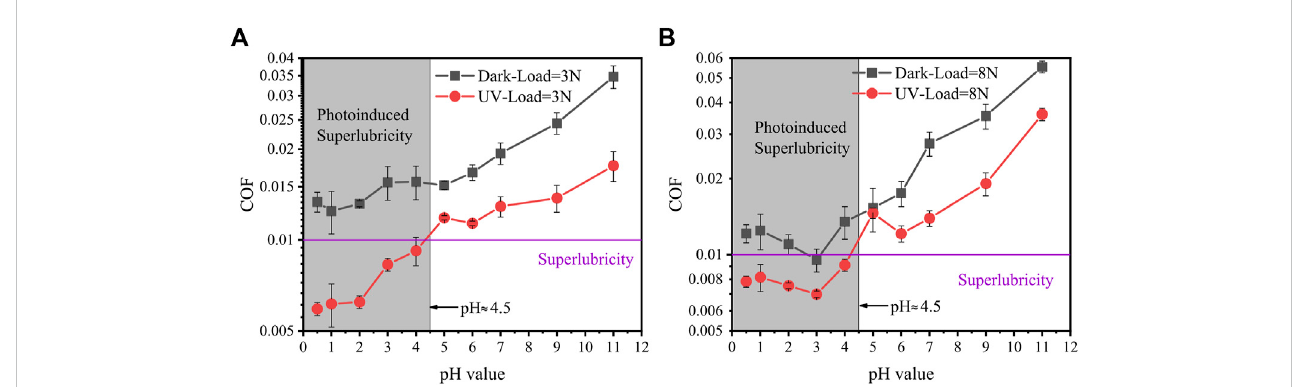
FIGURE 2 Coef fi cientoffrictionin70%glycerolsolutionchangedwiththeincreaseinthepHvalueofsulfuricacidsolutionaftertherunning-inprocessunderloads of (A) 3 N and (B) 8 N. After ultraviolet illumination, the red circles were always lower than black squares which were not ultraviolet treated.